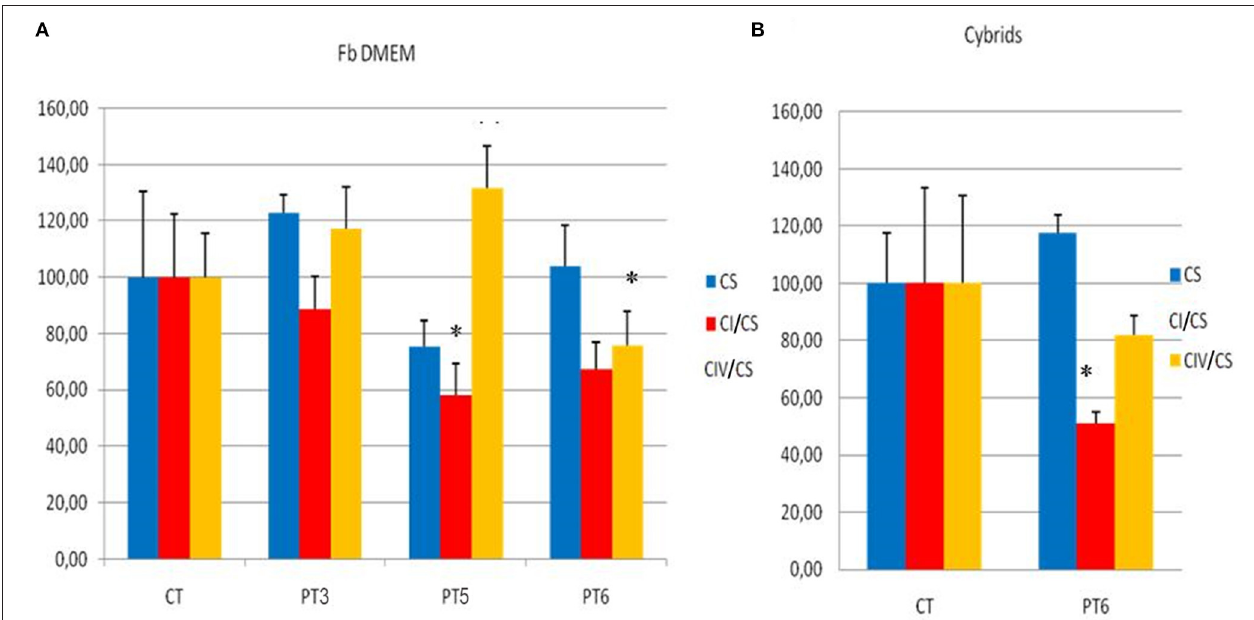
FIGURE 1 | Mitochondrial respiratory chain activities on fibroblasts and cybrids. (A) Mitochondrial respiratory chain activities of CI and CIV complexes in Patient 3 (PT3), Patient 4 (PT4), Patient 6 (PT6) fibroblasts, and mediated controls (six different fibroblast cell lines) cultured in glucose-rich DMEM medium. (B) Mitochondrial respiratory chain activities of CI and CIV complexes in Patient 6 cybrids cultured in glucose-rich DMEM (PT6) and 5 mediated trans-mitochondrial cybrids controls (CT) grown in the same medium. Enzymatic activities (nmol/min/mg of protein) are expressed in percentage compared to controls and normalized with citrate syntase (CS) activity (blue column). CI, complex I (red column); CIV, complex IV (orange column). Student’s t -test * p ≤